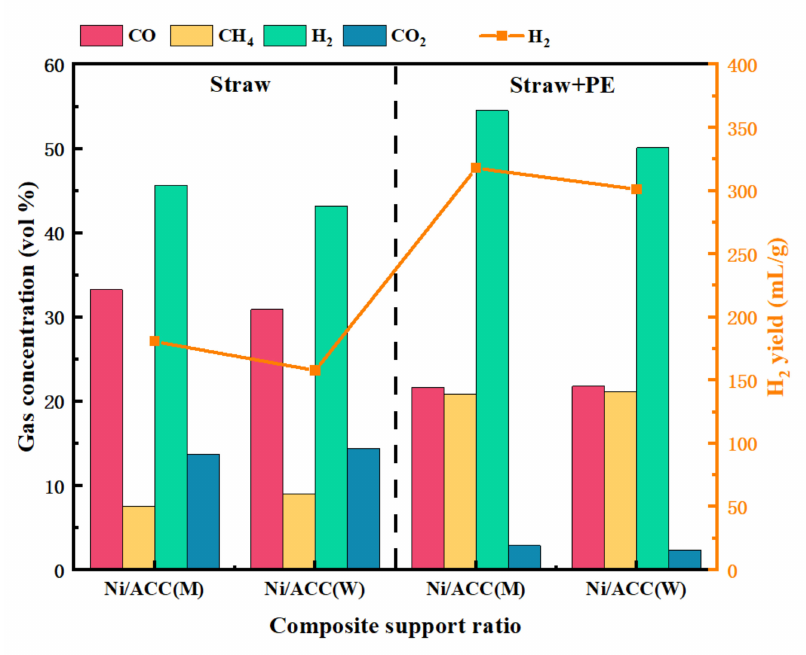
Figure 6. Effect of Ni/ACC support composite ratio on gas production.